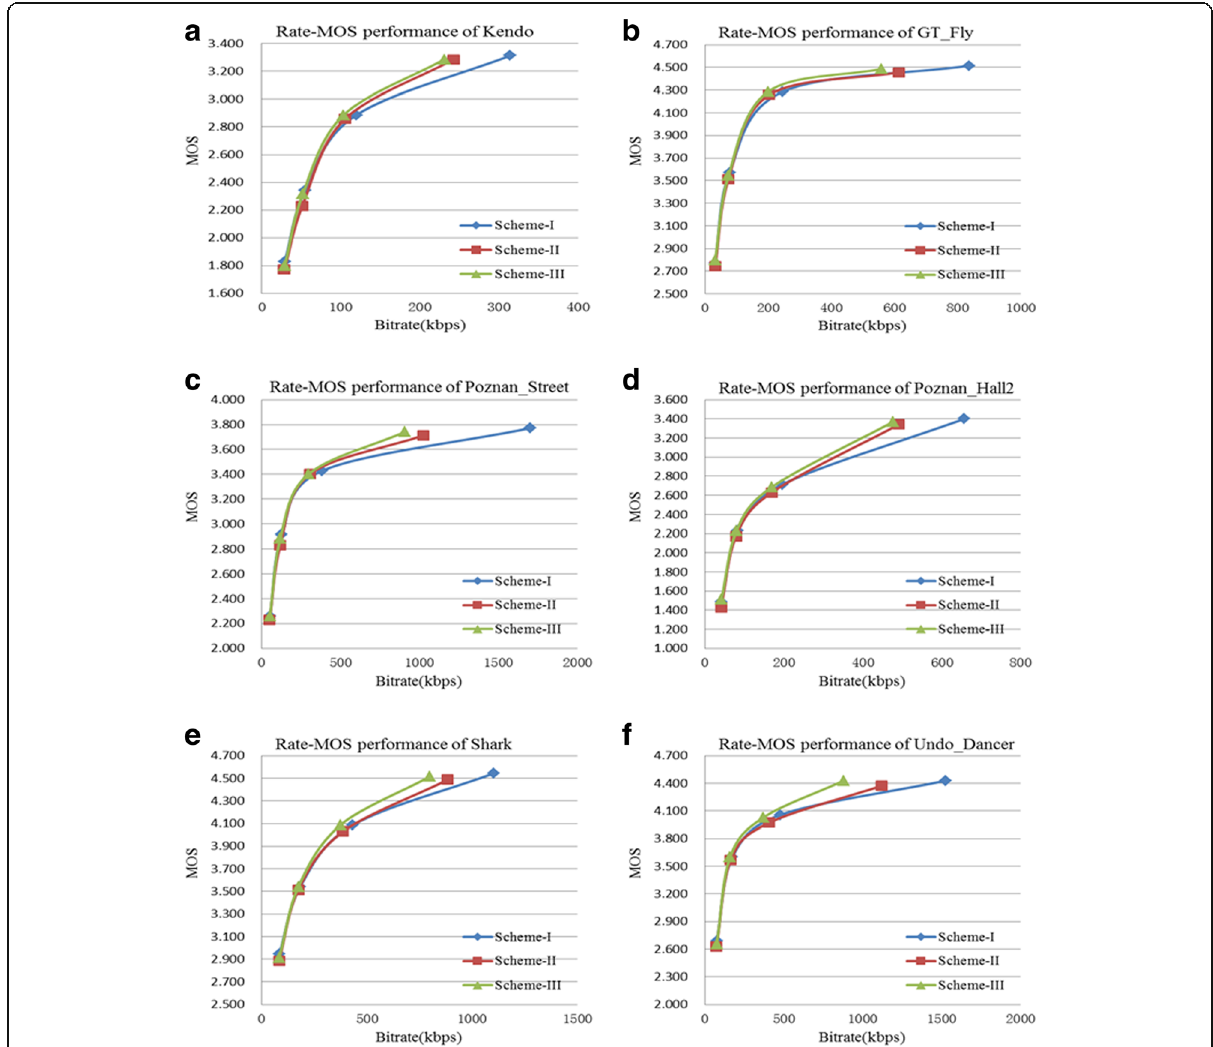
Fig. 10 The Rate-MOS performance comparisons of three schemes: a "Kendo," b "GT_Fly," c "Poznan_Street," d "Poznan_Hall2," e